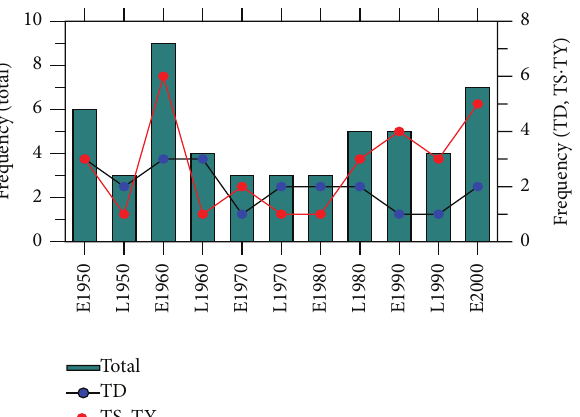
Figure 3: 5-year variation of the landfall frequency of Korea-landfall TCs. The bar and blue and red lines denote a 5-year total frequency, a TD and extratropically transitioned cyclone frequency, and a TS and TY frequency, respectively. Capital E and L denote “early” and “late,”